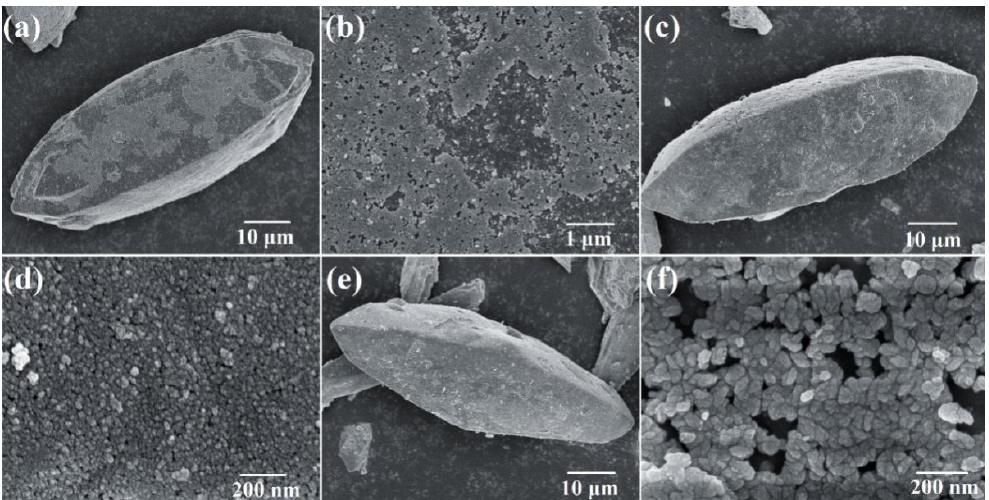
Figure 3. SEM images of ( a , b ) Sample 1 (initial Fe ions/scorodite molar ratio = 1%; initial reaction pH = 8; reaction time = 15 min), ( c , d ) Sample 2 (initial Fe ions/scorodite molar ratio = 9%; initial reaction pH = 8; reaction time = 15 min), and ( e , f ) Sample 3 (initial Fe ions/scorodite molar ratio = 9%; initial reaction pH = 8; reaction time = 35 min).